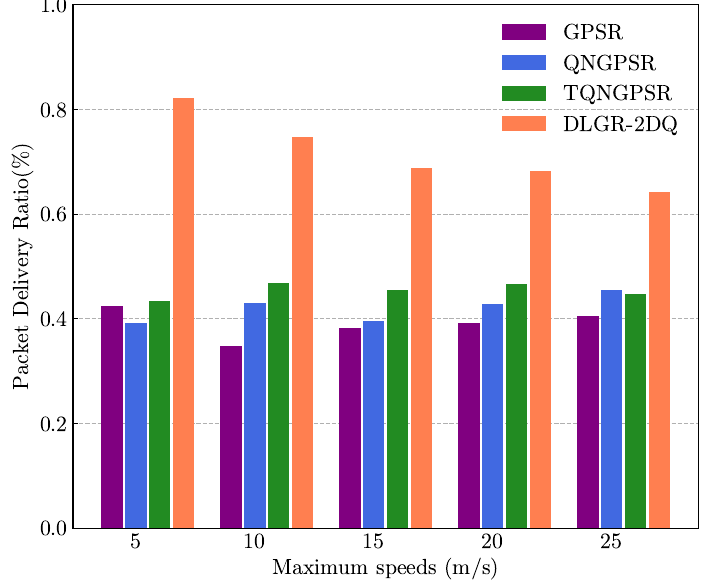
Figure 10. The effects of maximum speed on PDR.